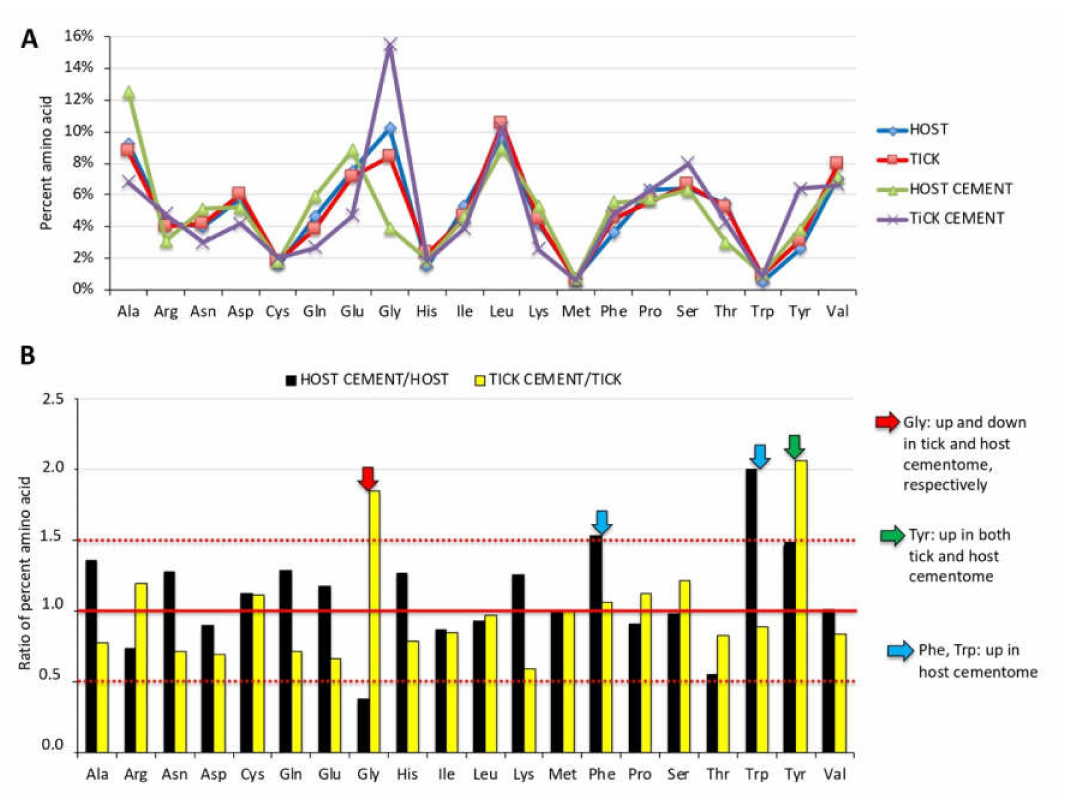
Figure 7. Amino acid composition of tick cementome. ( A ) Amino acid composition of all host proteins identified in the cementome but not in the sialome (HOST), 100 randomly selected tick proteins identified in the sialome but not in the cementome (TICK), all host proteins identified in the sialome and cementome (HOST CEMENT), and all tick proteins identified in the cementome (TICK CEMENT) (Data S6) were analyzed using the ProtParam tool. ( B ) Amino acids with highest changes (0.5 ≥ ratio of percent amino acid ≥ 1.5) in the cementome composition when compared to non-cementome host-derived (host cement / host) or tick-derived (tick cement / tick)